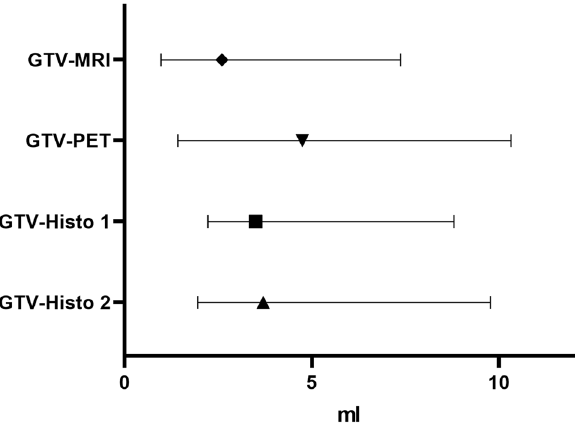
Figure 3. Volumes after final co-registration. Displayed are 3D volumes of histology reference after final co-registration (GTV-Histo 1 and GTV-Histo 2). Additionally volumes contoured in mpMRI (GTV-MRI) and [ 18 F]PSMA-1007 PET (GTV-PET) are represented. The median and interquartile ranges over all patients are